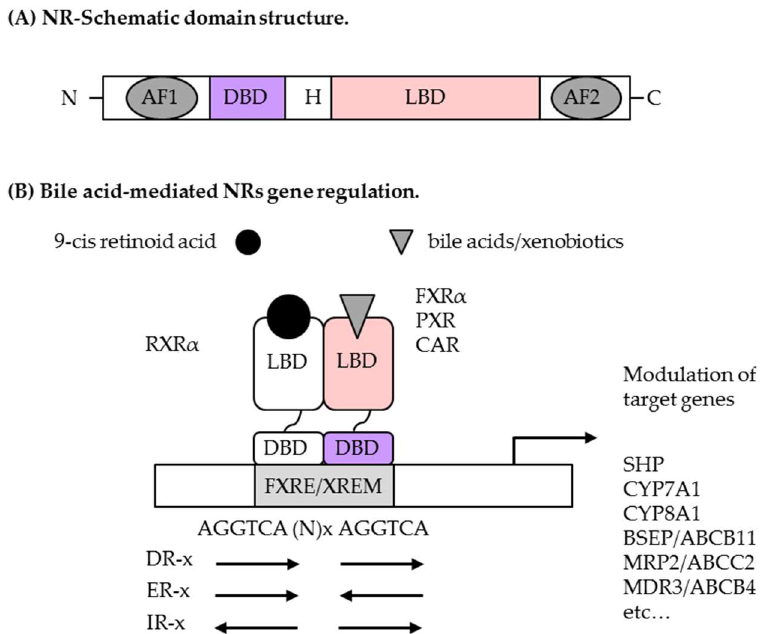
Figure 1. Structural organization and mechanism of action of nuclear receptors. ( A ) Structural organization of hormone nuclear receptors. AF-1, activation function 1; DBD, DNA binding domain; H, hinge region; LBD, ligand binding domain; AF-2, transactivation function 2. ( B ) A current model of NR-mediated gene regulation. Bile acid-activated NRs (FXR α , PXR, CAR) act mainly as heterodimers with retinoid X receptor α (RXR α ) to regulate gene transcription. FXRE, FXR α response element; XREM, xenobiotic response element; DR, direct repeat; ER, everted repeat; IR, inverted repeat.